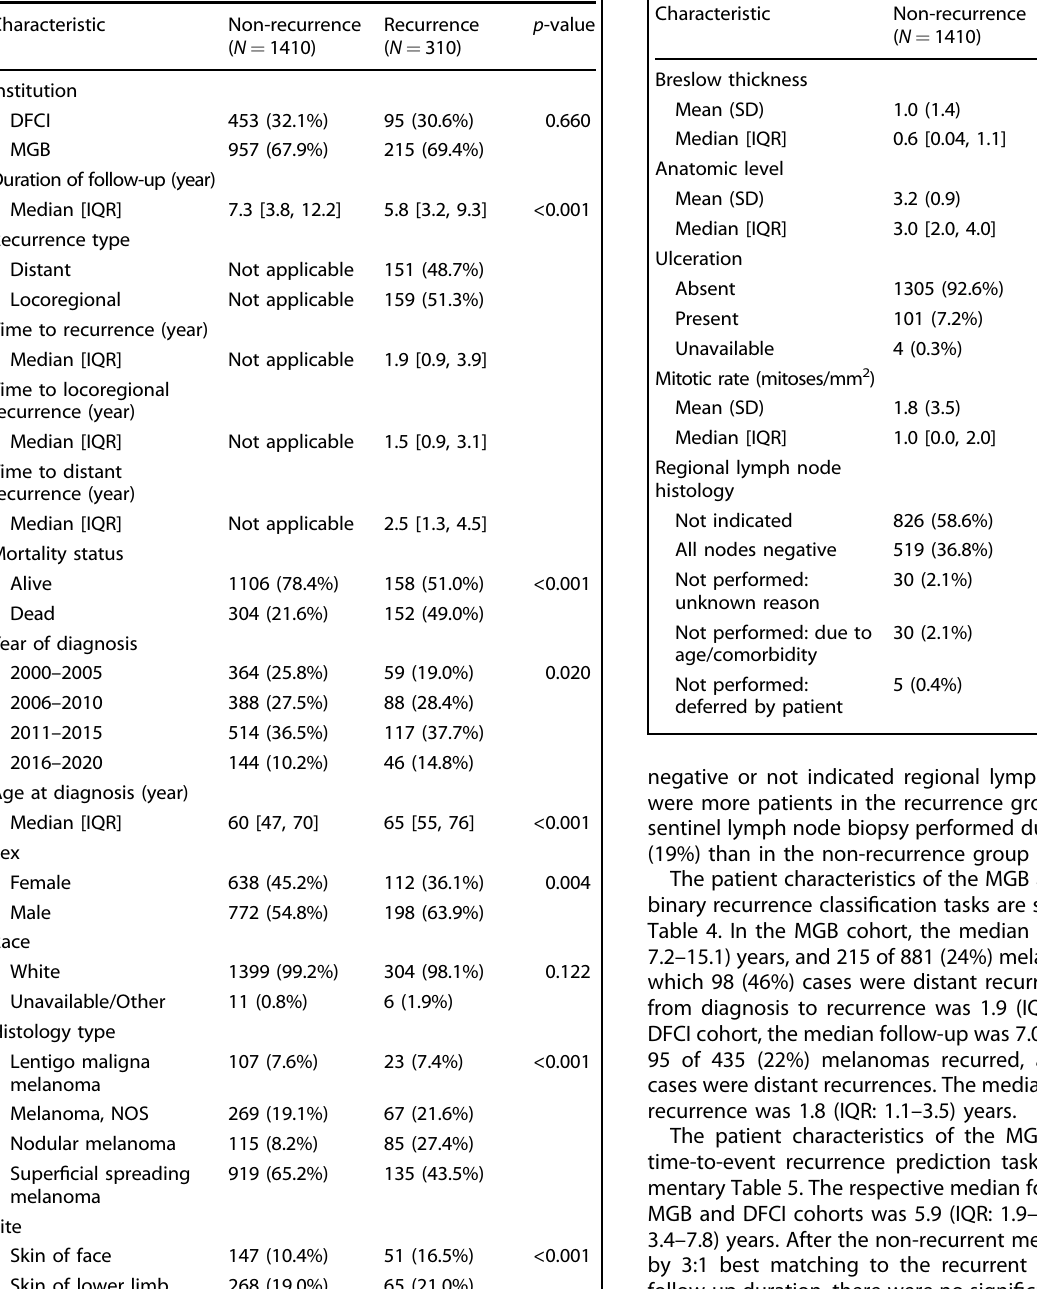
Table 1. Characteristics of the study